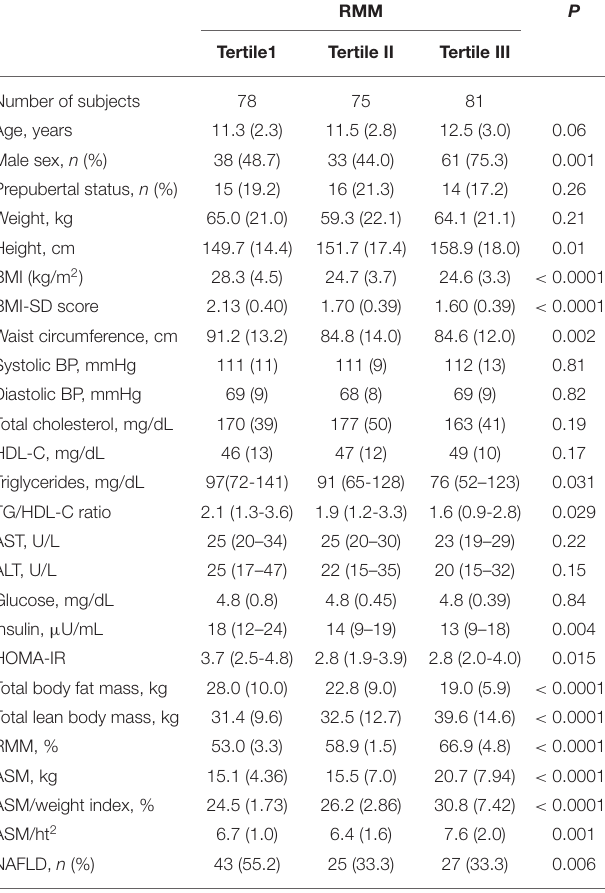
TABLE 1 | Characteristics of study population according to tertiles of RMM a . TABLE 2 | Age-, gender, and pubertal status- adjusted linear regression